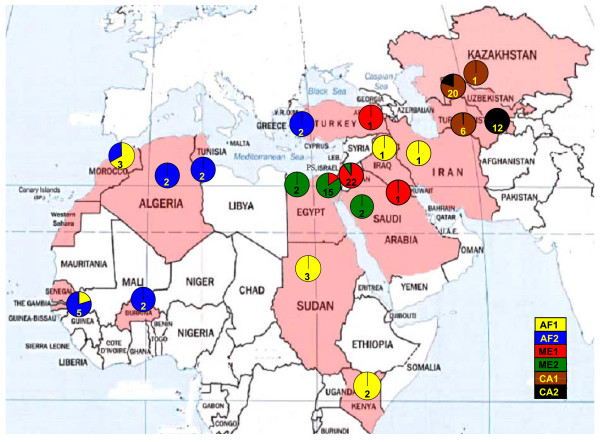
Distribution of different sub-populations of L. (Leishmania) major in the three main geographical regions. Populations CA1, CA2, ME1, ME2, AF1 and AF2 are labelled with different colours. The percentage of strains from a given focus belonging to these populations is shown as a pie diagram, which also shows the number of strains collected there. PS = The Palestinian Authority.